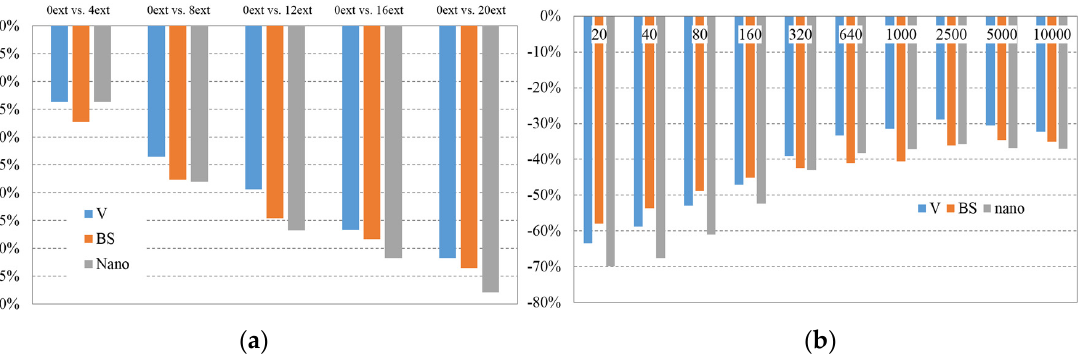
Figure 6. ( a ) Average Variation of Viscosity value at 170 °C by number of extrusions (compared versus 0 extrusions batch); ( b ) Viscosity value variation at 170 °C by shear rate (compared 0 extrusions versus 20 extrusions batch).